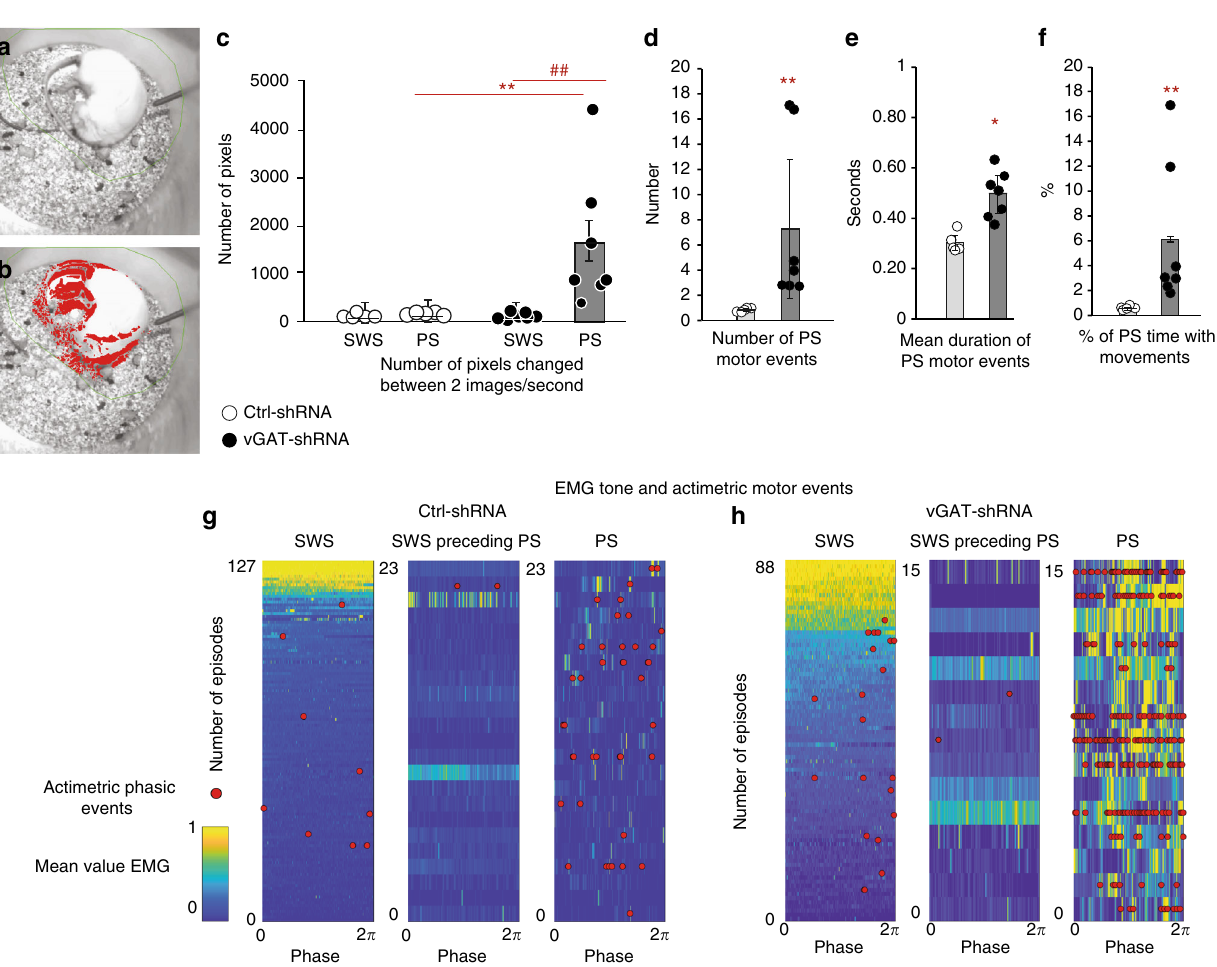
Fig. 5 RBD-like behaviors are displayed during PS after the genetic inactivation of GABA/glycine vmM neurons. a , b Examples of captured video images of representative Ctrl-shRNA ( a ) and vGAT-shRNA rats ( b ), both during a PS episode. Each red point corresponds to a gray color changed pixel between two successive images (see Materials and Methods sections). The density and location of red points respectively re fl ect intensity of rat ’ s movements and body territories where they occurred. c Histogram comparing in both rat groups the mean actimetry per second of SWS and PS calculated by counting the number of changed pixels between two successive video images due to animal movements. Oneiric movements appear only during PS in vGAT-shRNA rats. d , e Histograms comparing in bot rat groups the mean number of motor events per PS bout ( d ) and the mean duration of motor events (in seconds, e ) per PS episode. f Histogram showing the percentage of PS time with movements in both rat groups. Note that all actimetry parameters calculated thanks to video recordings and that directly re fl ect the movements displayed by rats during PS are signi fi cantly higher in vGAT-shRNA vs. Ctrl-shRNA animals.